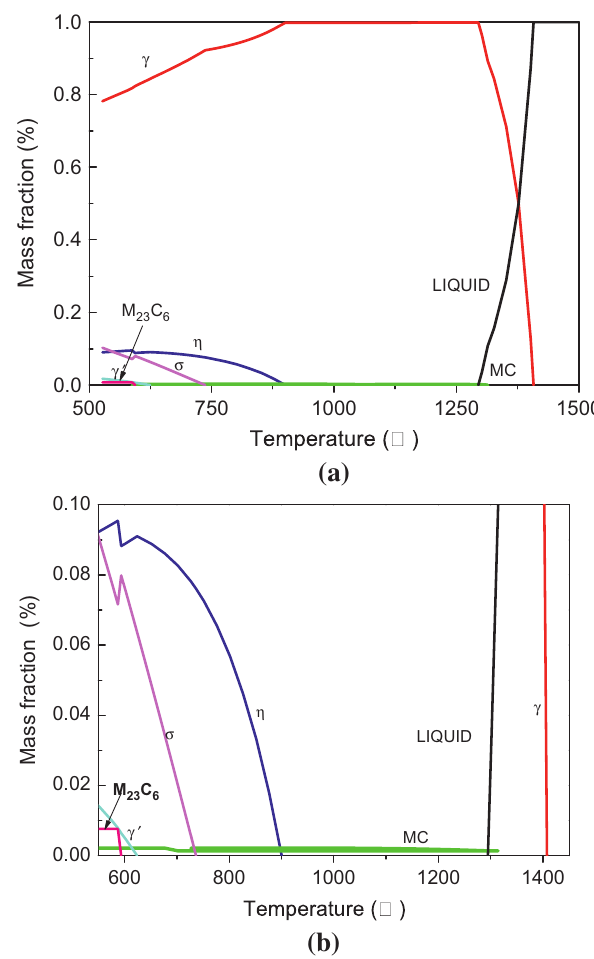
Figure 2: Variation of equilibrium phase content with temperature (a) and its partial enlarged detail (b).